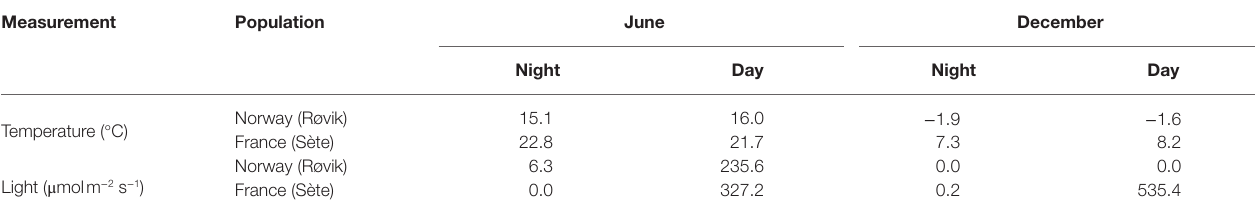
TABLE 1 | Snapshots of temperature and light conditions measured at the sampling